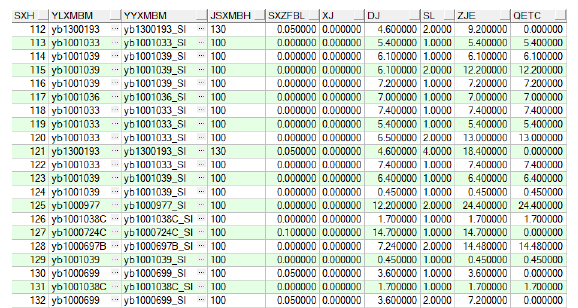
Fig. 5 Example of original healthcare insurance records.